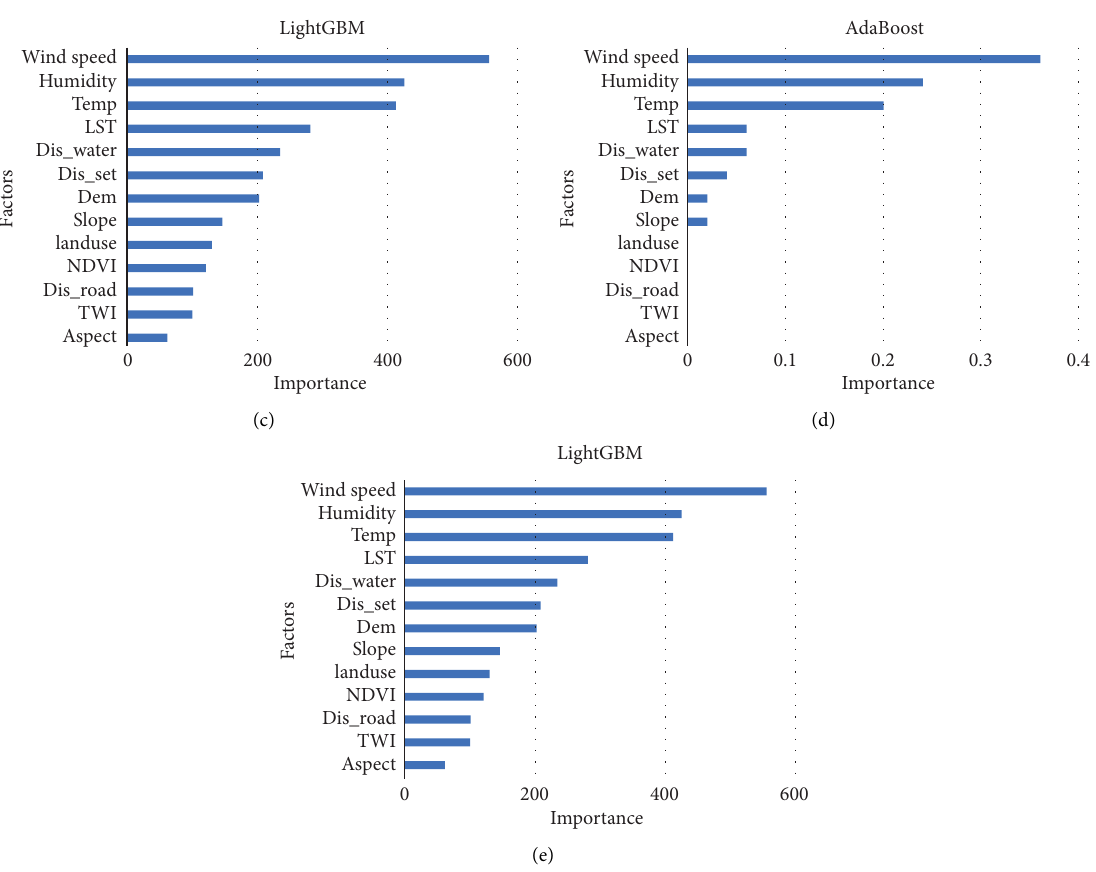
Figure 6: Importance degrees of the factors used in this study according to all the models: (a) XGBoost, (b) CatBoost, (c) GBM, (d) AdaBoost, and (e)